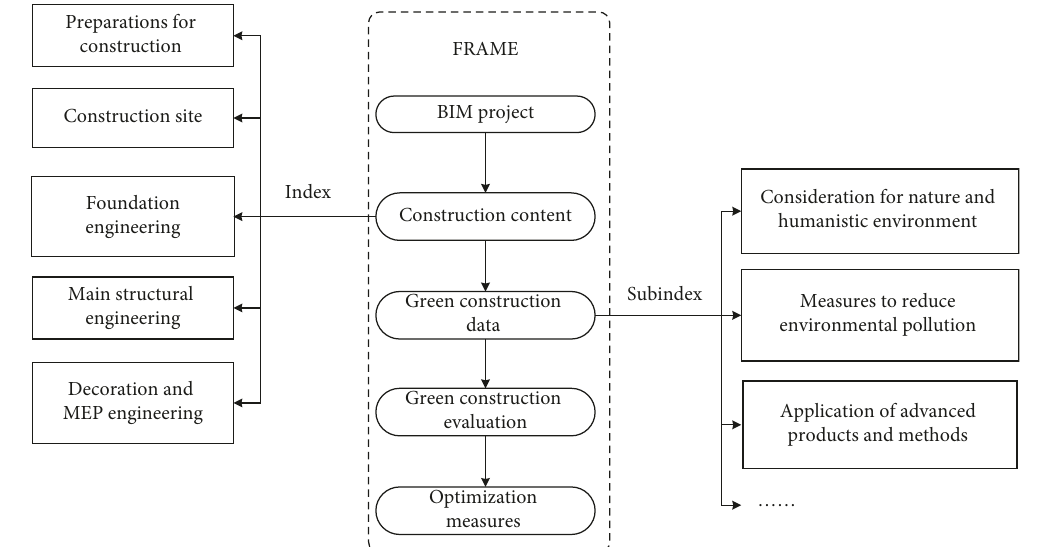
Figure 7: Concept of BIM construction